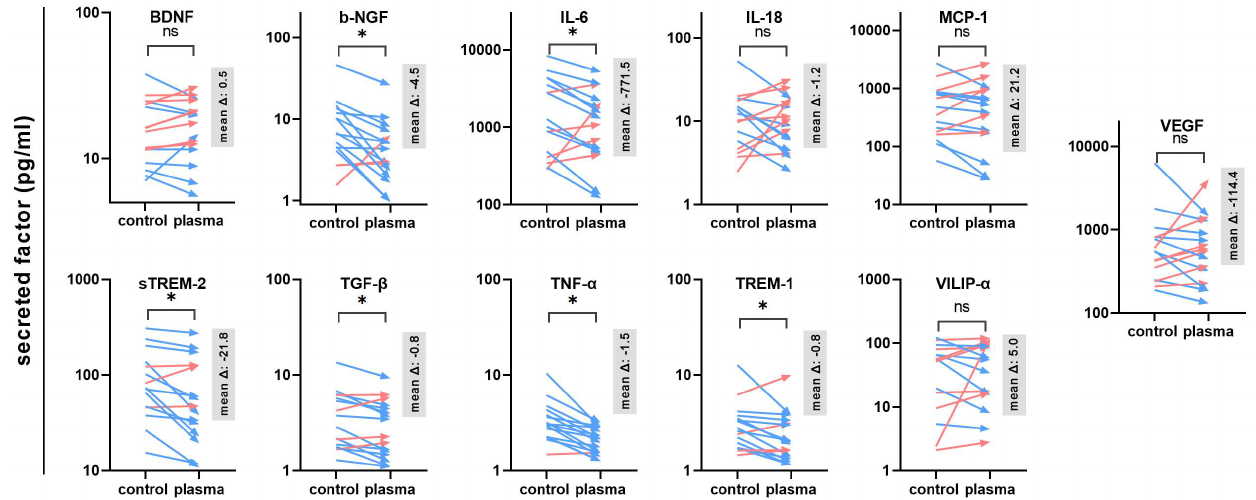
Figure 4. Secretion profiling of patient-derived GBM tissues. A total of 11 cytokines, chemokines, and growth factors were analyzed in the supernatants of untreated or gas plasma-treated patient-derived glioblastoma multiforme (GBM) tumor biopsies cultured for 24 h. Data are from 15–16 donors and show mean of each donor and control and treatment group (red: increase, blue: decrease) with mean delta (Δ) given in gray boxes; statistical analysis was performed based on normality distribution using either a paired t -test or two-tailed Wilcoxon rank test with p < 0.05 (*) differing significantly or non-significantly (ns).